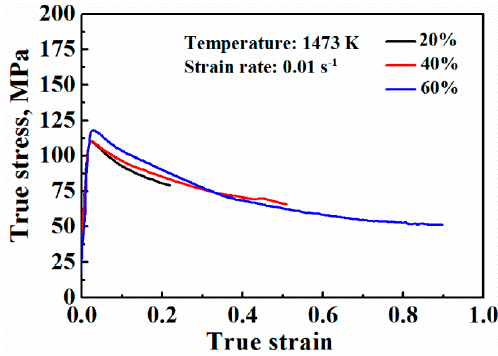
Figure 3. True stress-strain curves of the as-cast Ti-44Al-4Nb-1.5Cr-0.5Mo-0.2B alloy.